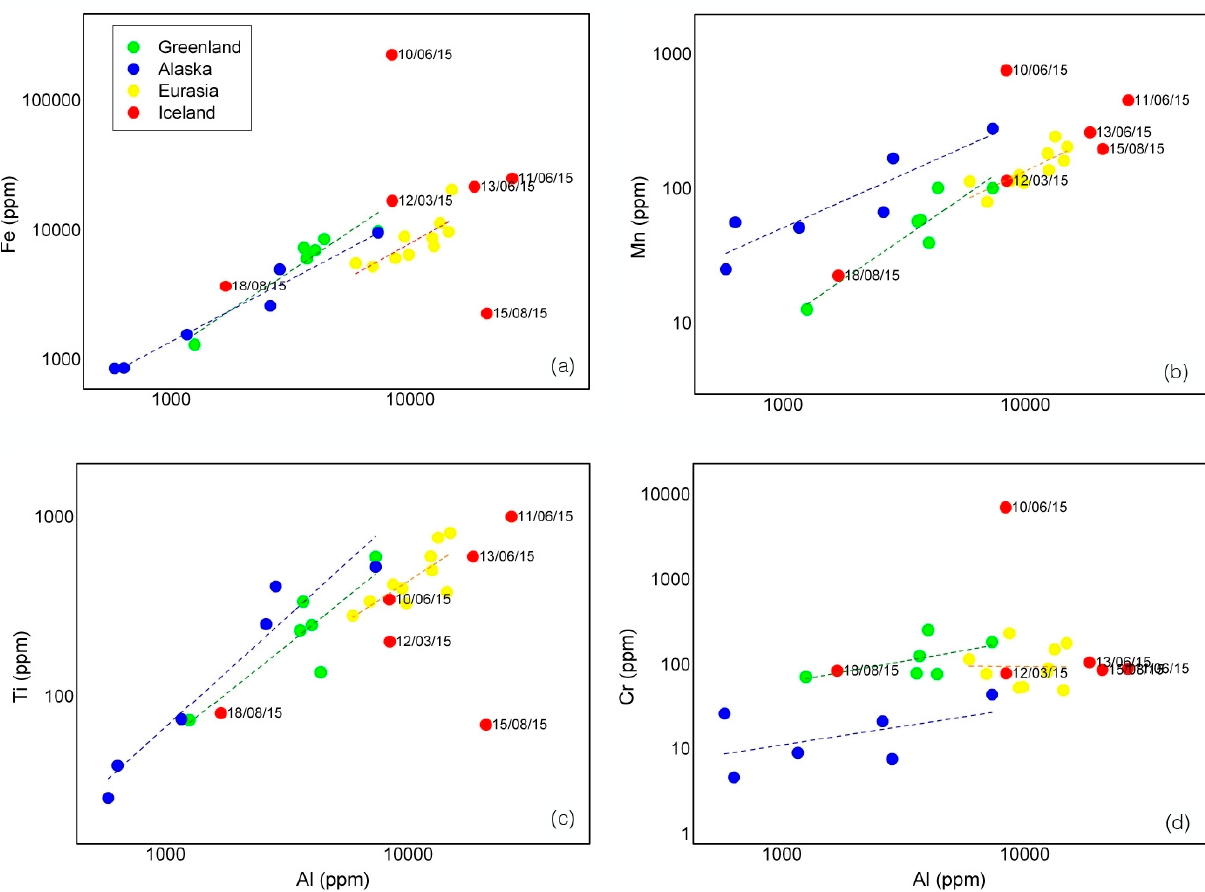
Figure 5. Correlation diagrams and regression lines of the metals in the daily aerosol samples sorted on the basis of detected source areas (Eurasia, Iceland, Greenland and Alaska).